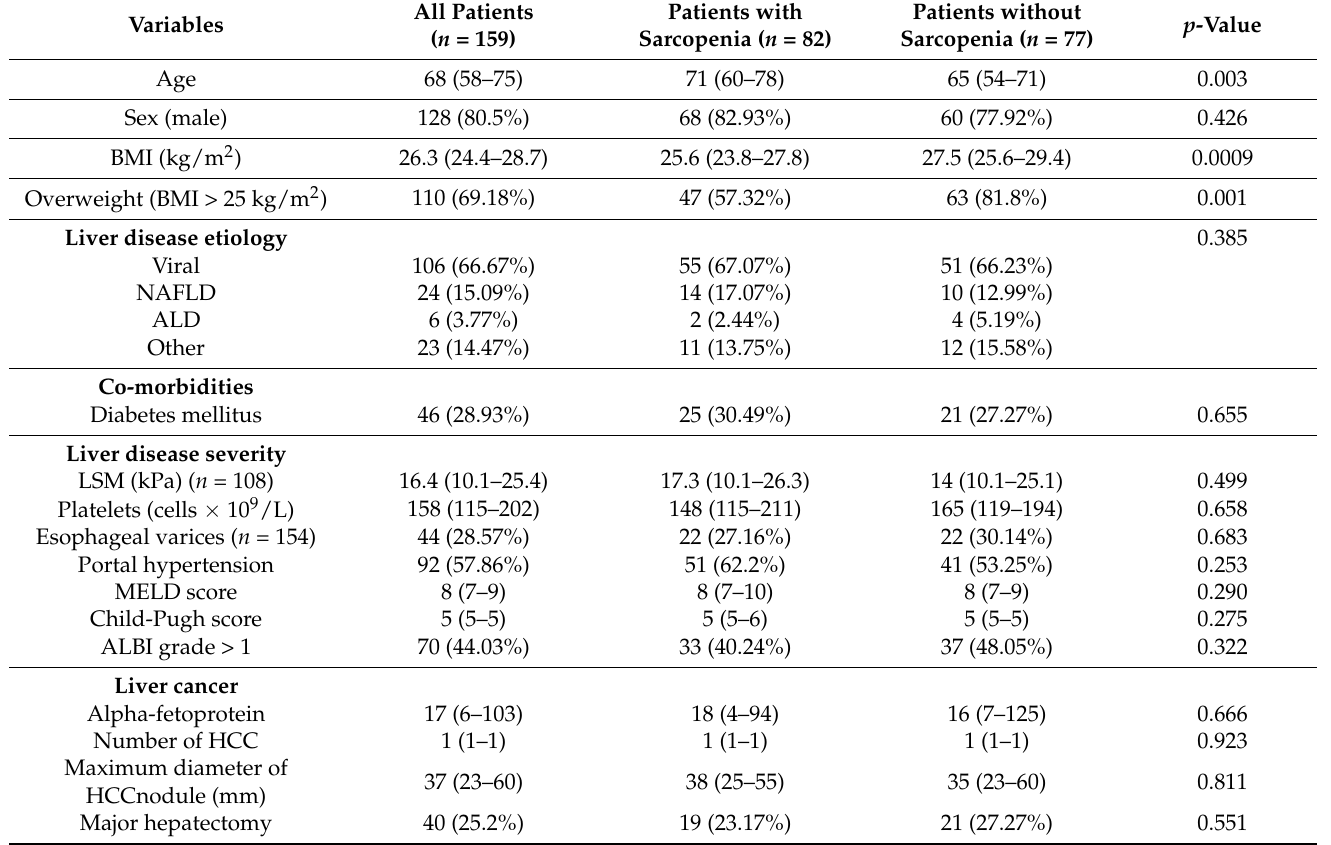
Table 1. Characteristics of the patients included in the study.